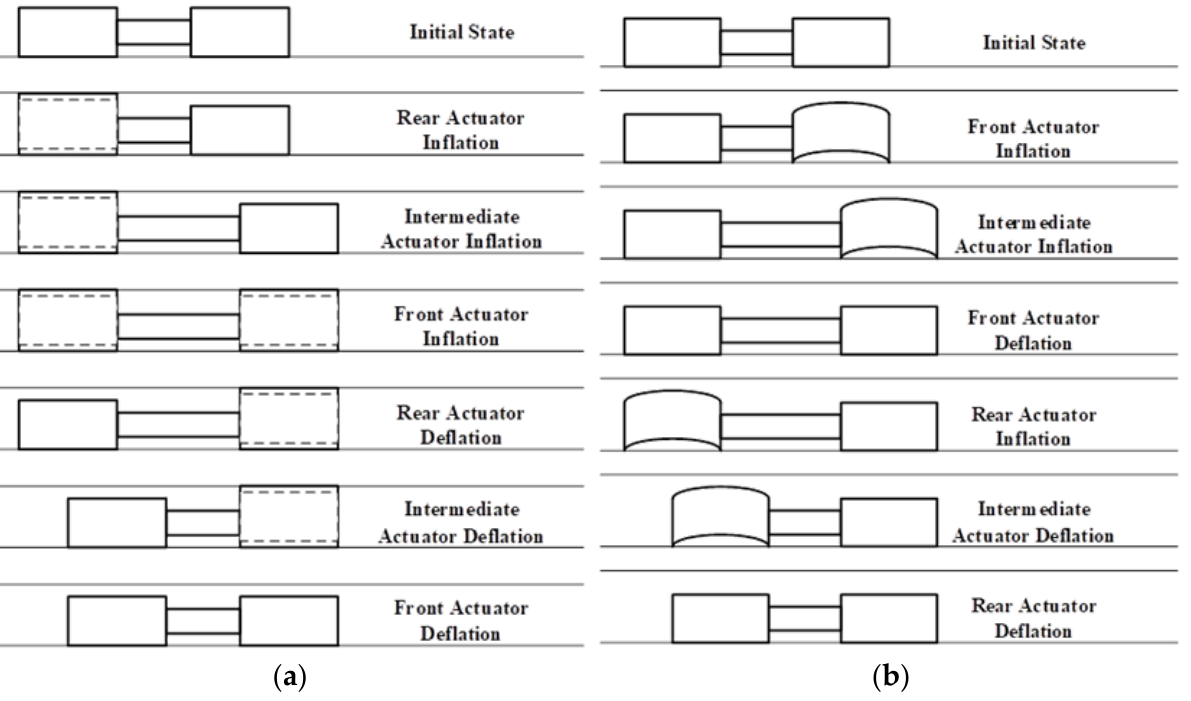
Table 1. Main structural parameters of the actuator. No.